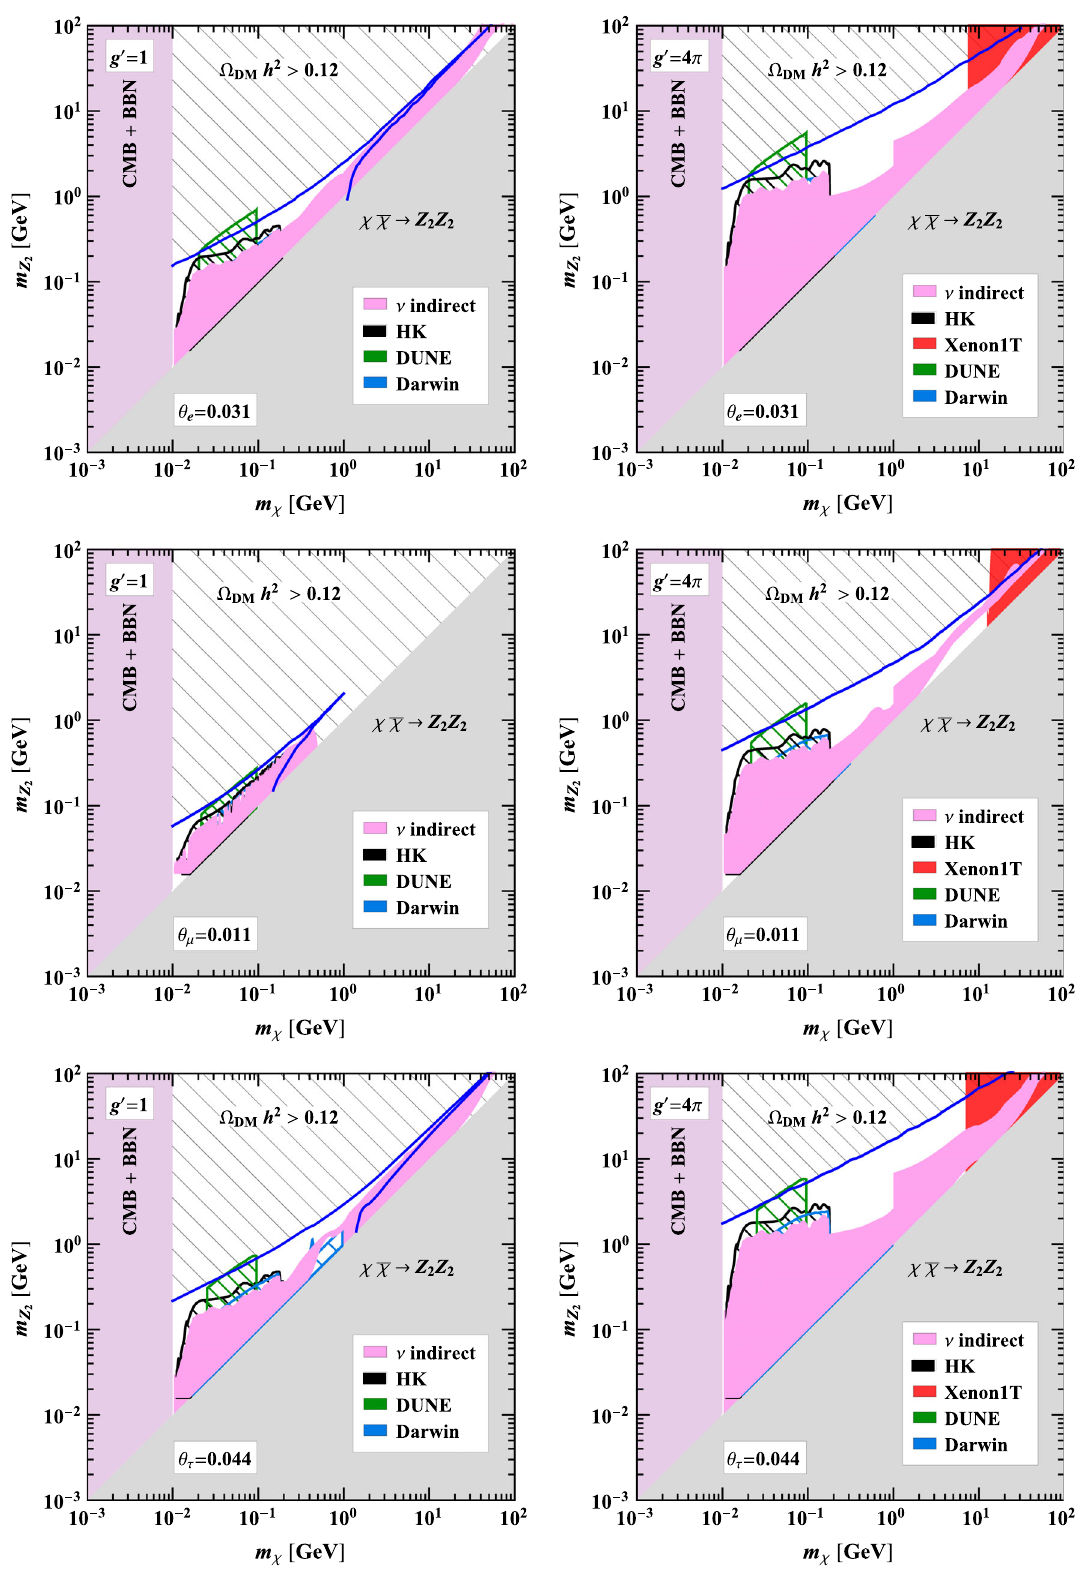
Fig. 10 Constraints on the DM mass m χ and m Z lines, computed with micrOMEGAs , the DM relic density matches the observed value. The coloured shaded regions are excluded by different